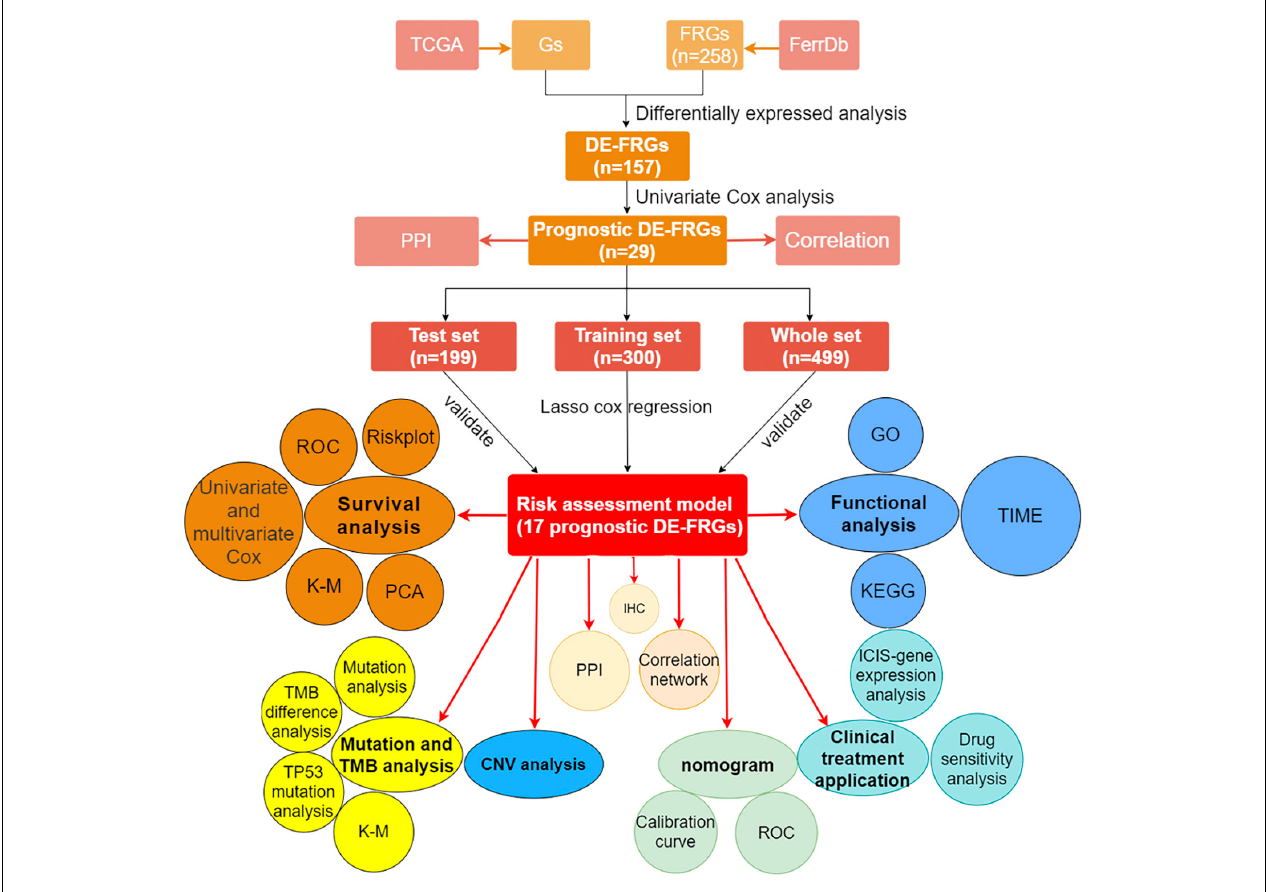
FIGURE 1 | The workflow of research